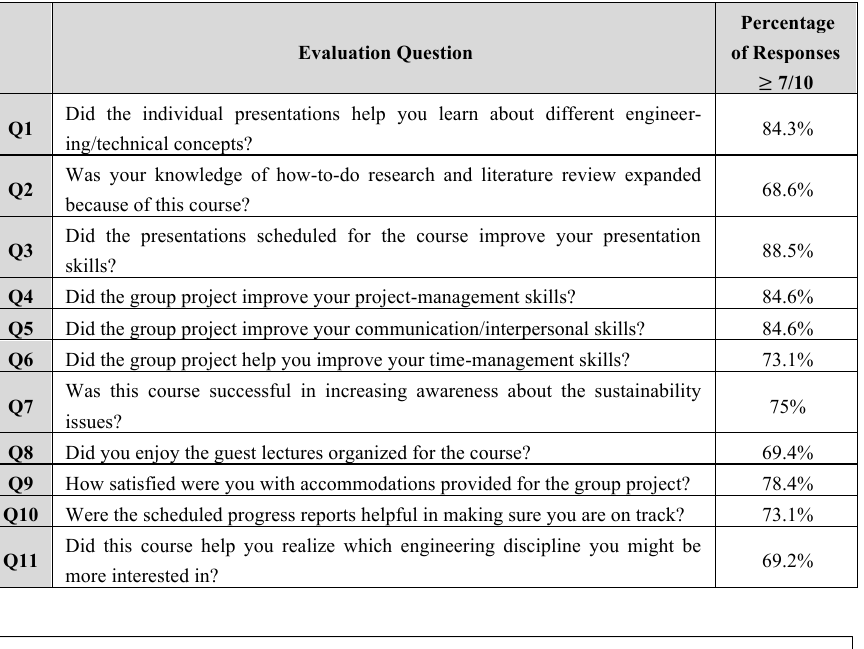
Table 4. Survey questions and percentage of responses with answers